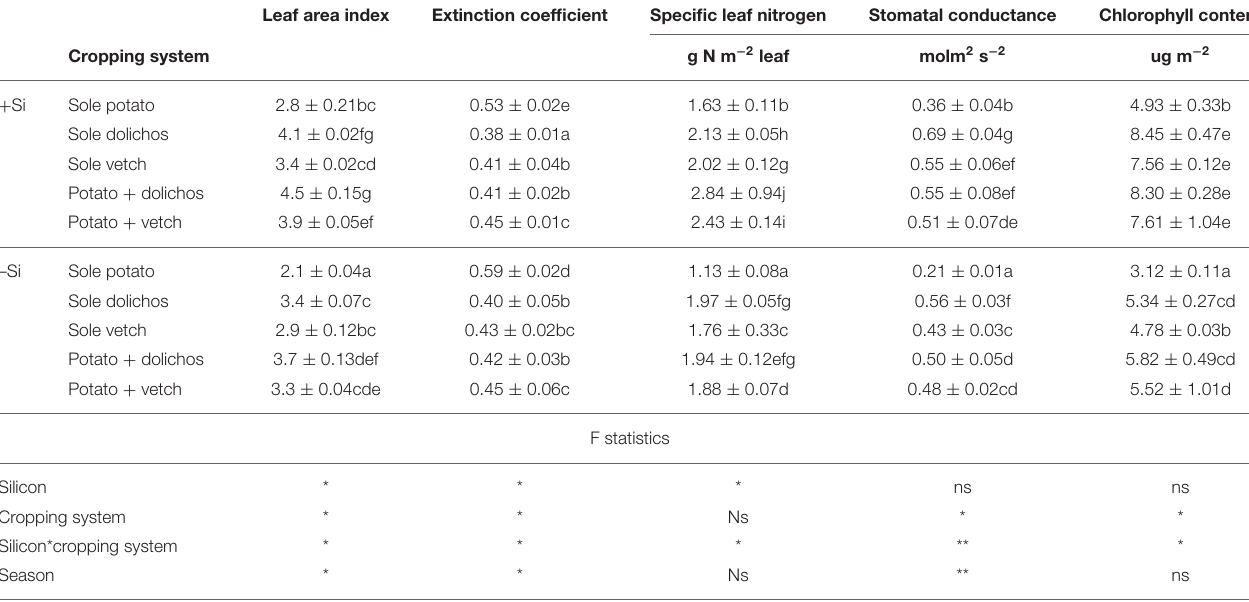
TABLE 3 | Effect of silicon application and legume intercropping on leaf are index, leaf orientation, leaf nitrogen, stomatal conductance, and chlorophyll content.